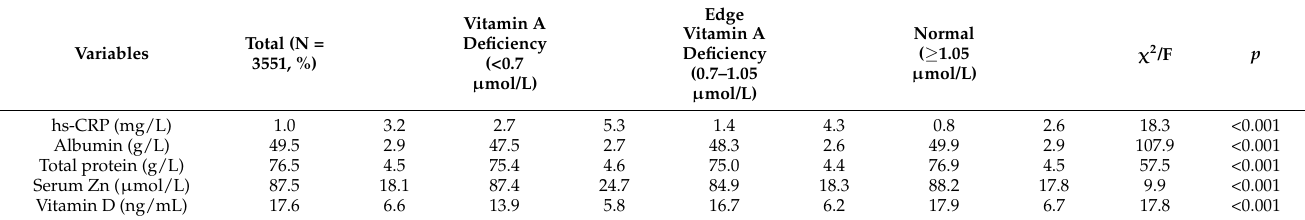
Figure 2. Change in blood lipids with age for different sexes. Means and standard error of the means are shown.